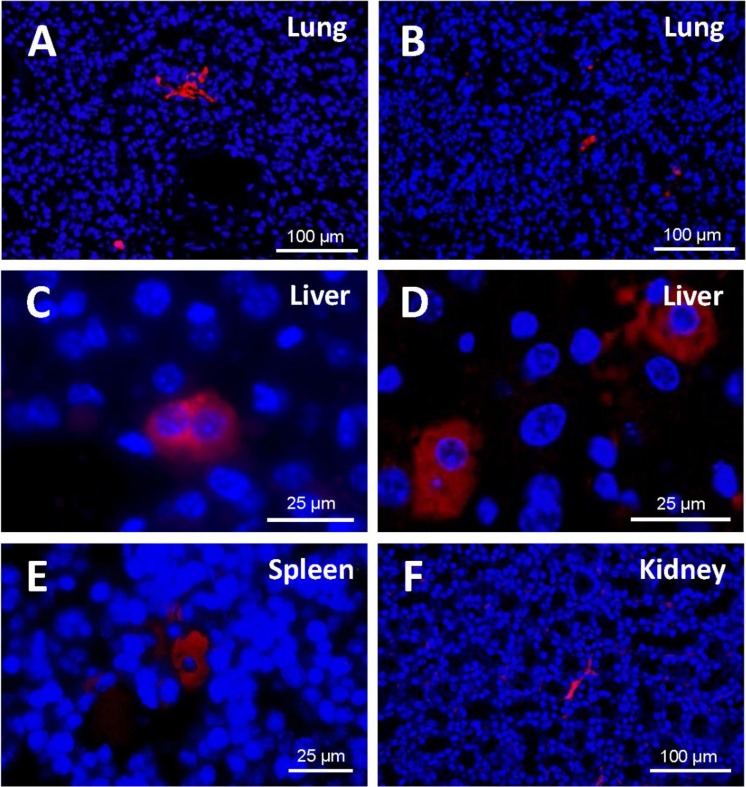
Detection of EGFP-positive cells (red) in tissue sections from cell-treated mice using immunofluorescence.Nuclei are counterstained with DAPI (blue). (A) Cell masses located in lung sections at 48 h and (B) 5 days after cell injection (original magnification 20×). At 48 h from injection, EGFP-positive cells were to be found mostly in the lung, in the form of clusters. A slight decrease in the number and size of those cell aggregates occurred at 5 days. (C) Binucleated cells expressing EGFP are observed in the liver (48 h). Cell morphology varied depending on the host tissue. (D) Liver-engrafted positive cells often show a hepatocyte-like morphology (5 days) (zoomed images from an original magnification 63×). In some mice, EGFP-positive cells are found in spleen (E) and kidney (F) (original magnification 63×and 20×, respectively). Fluorescent cells in the spleen adopted a polygonal appearance, whereas those in the kidney preserved the fibroblastic shape that characterizes ASCs.